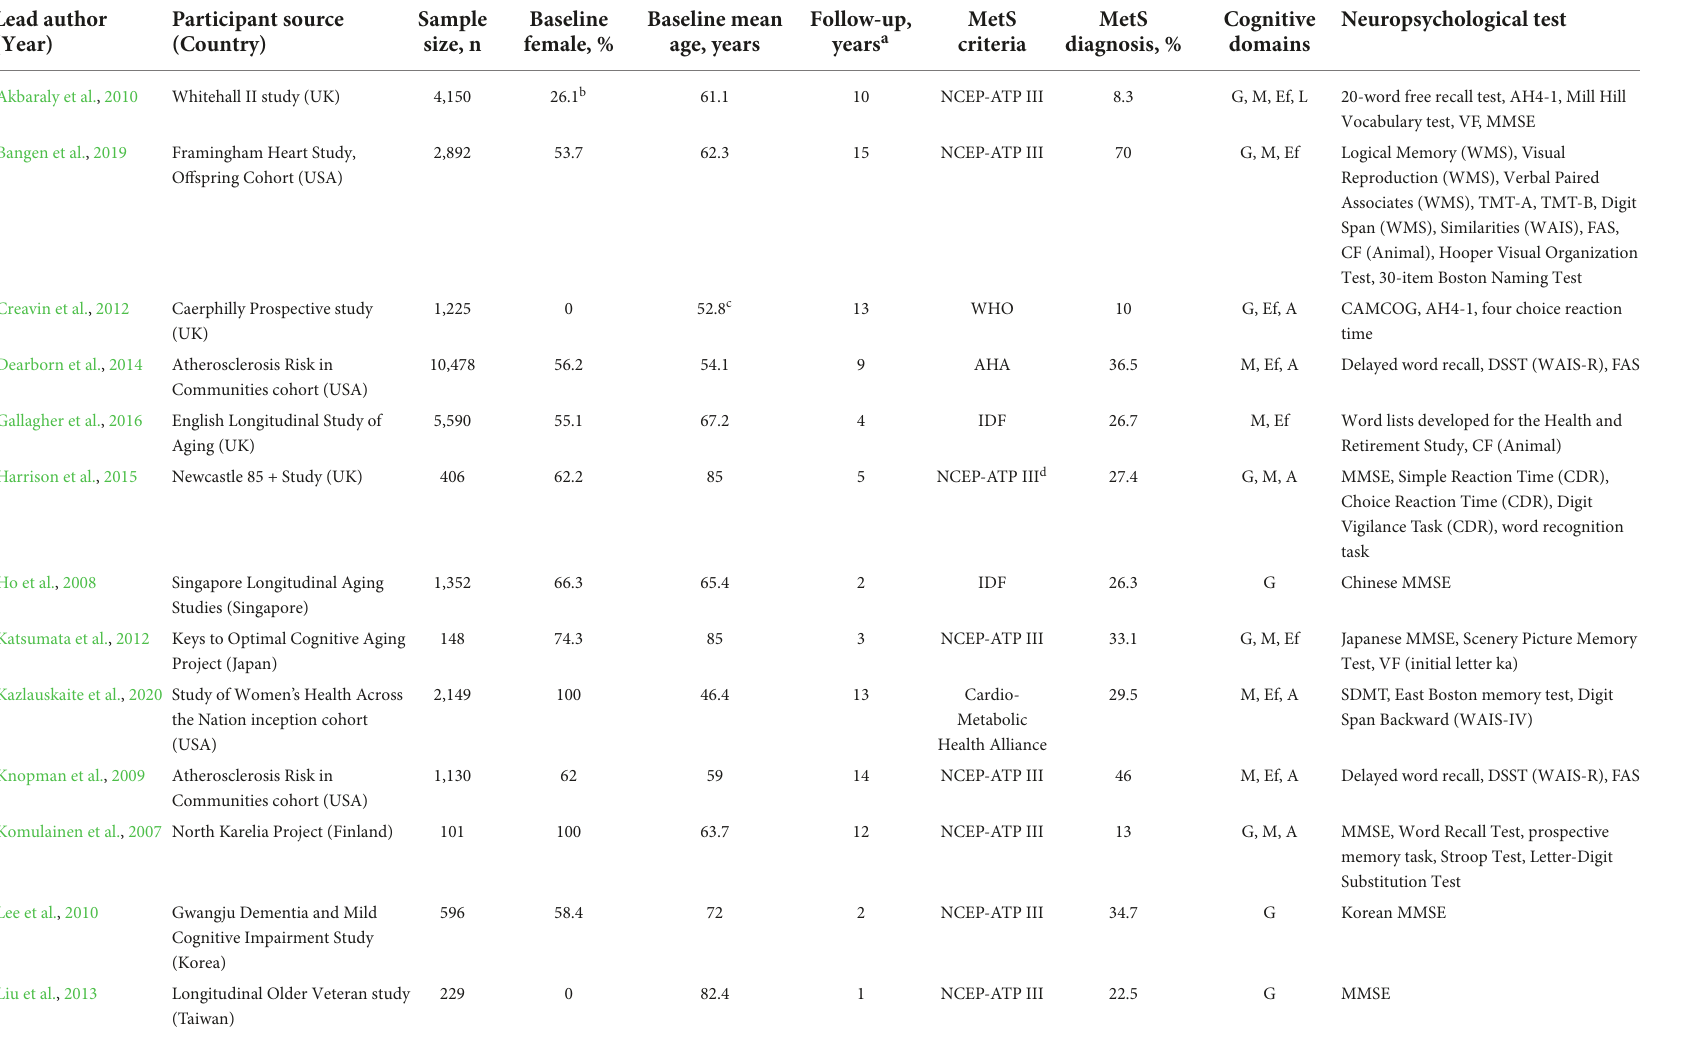
TABLE 2 Basic details of the studies included in the systematic